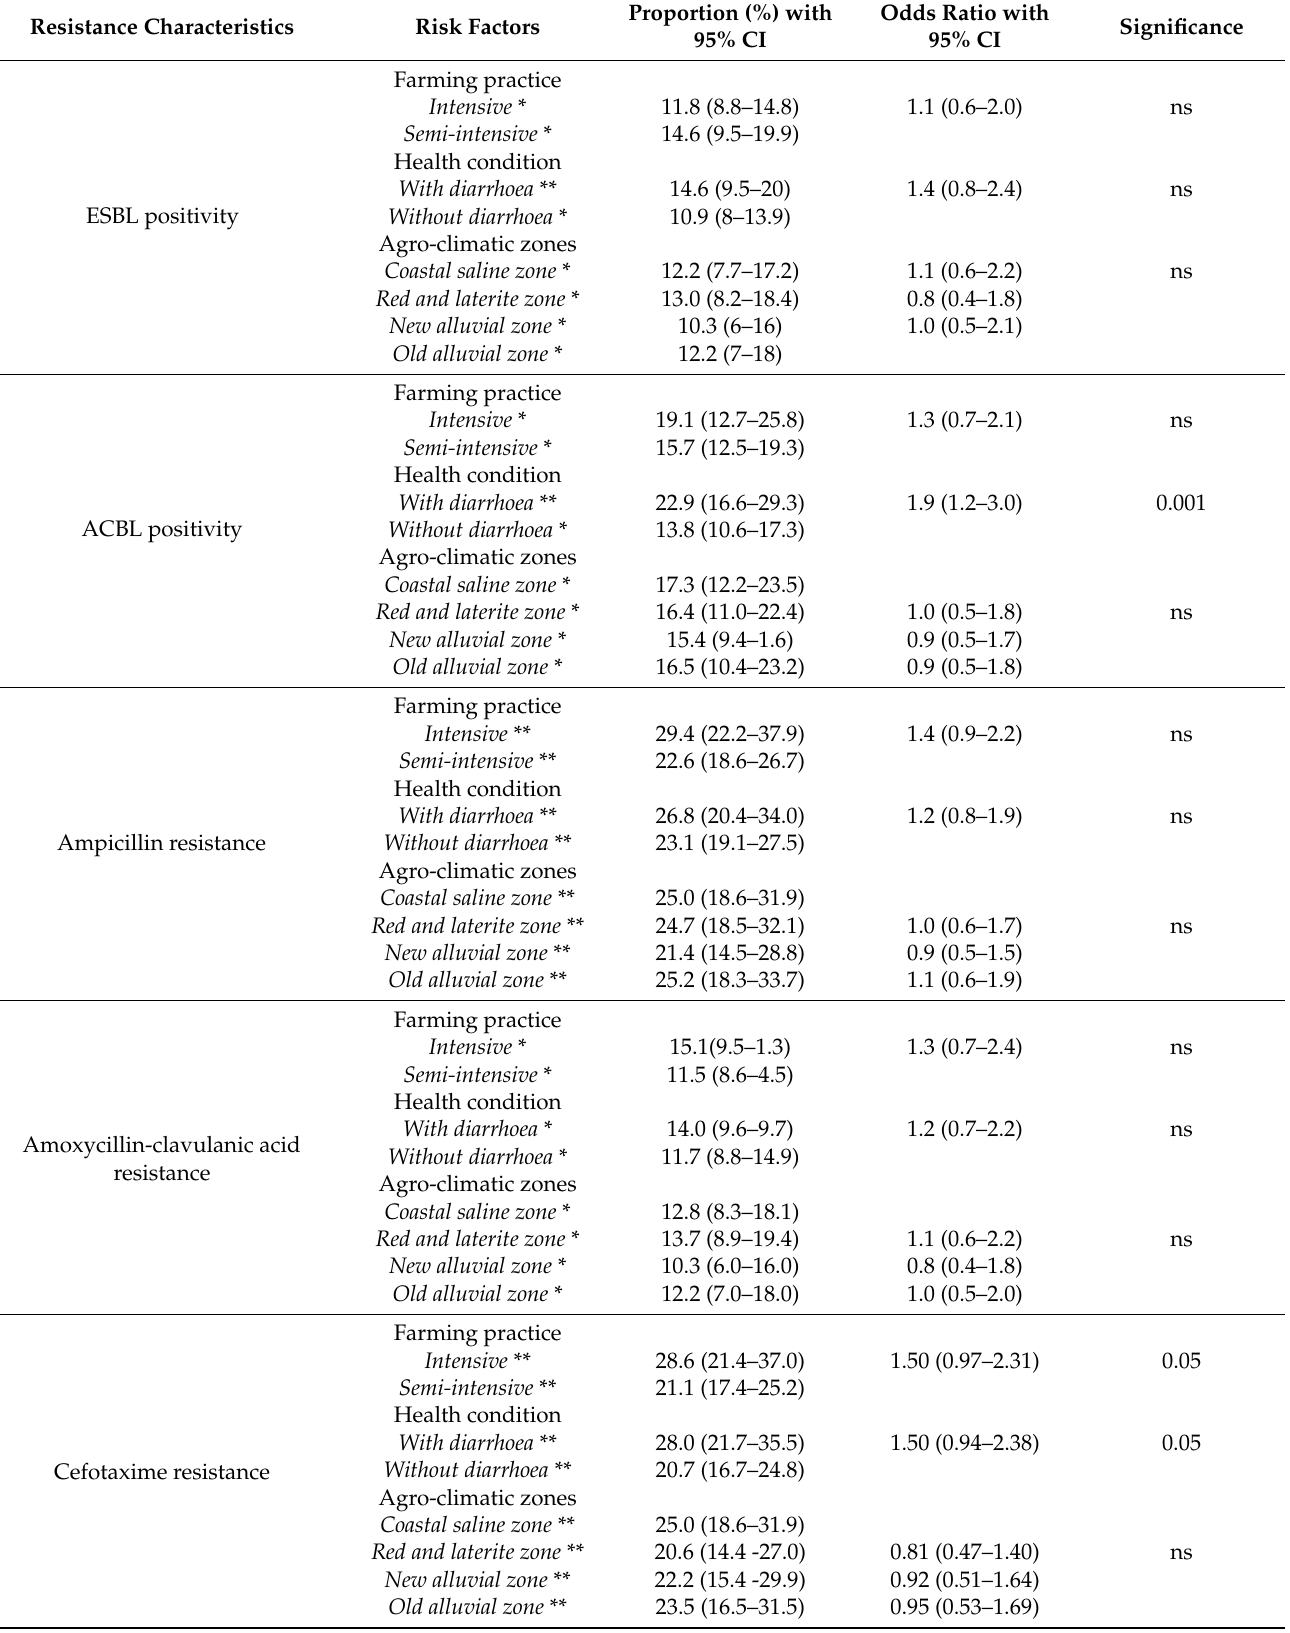
Table 1. Different risk factors contributing to the resistance characteristics of caprine Escherichia coli